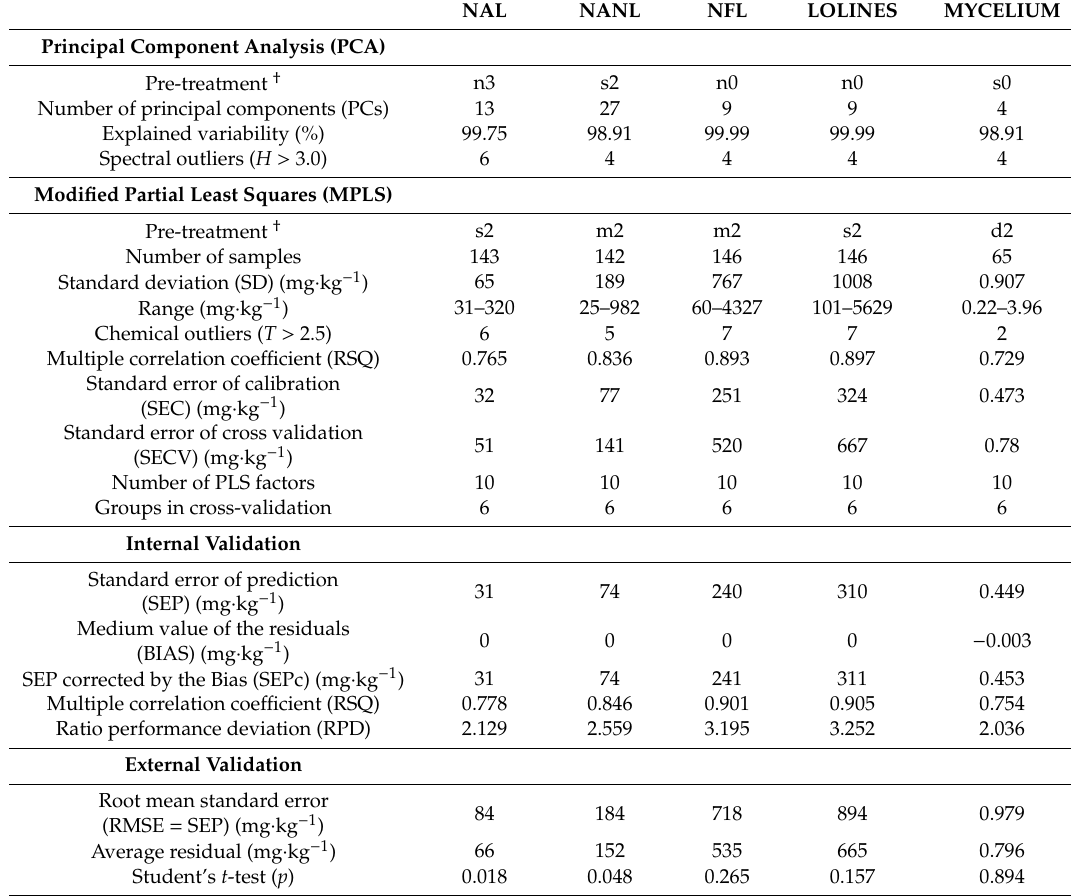
Table 3. Statistical parameters obtained from the equations developed for quantification of in planta concentrations of loline alkaloids and fungal biomass applying the modified partial least squares regressions in the NIR spectra of the meadow fescue